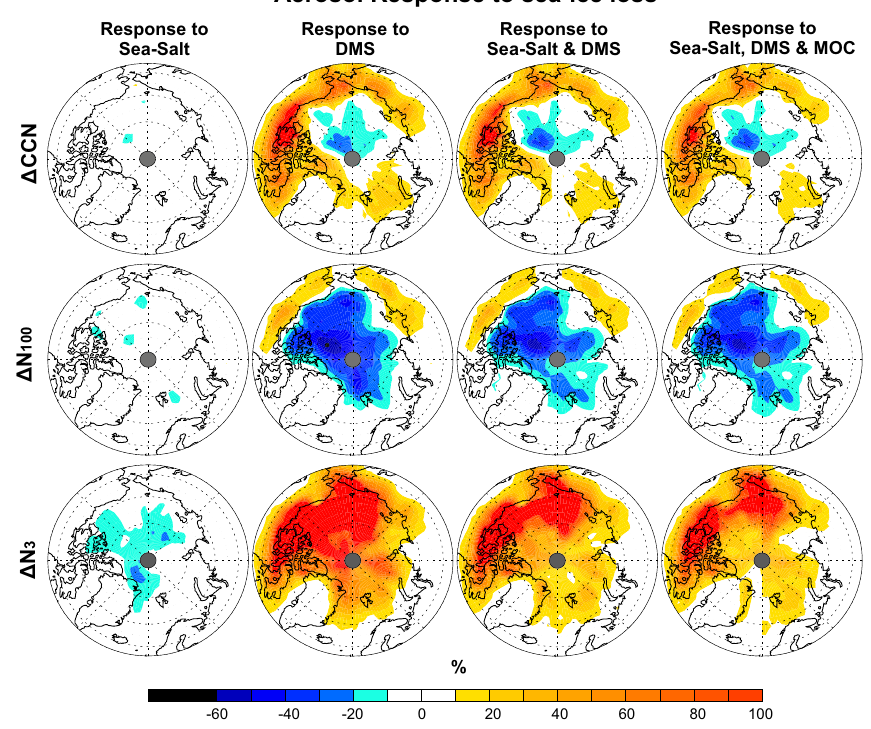
Figure 4. Response of modelled surface level aerosol concentrations due to complete loss of sea ice: CCN (top), N 100 (middle) and N 3 (bottom). Different aerosols and precursors are allowed to respond to the ice loss: sea-salt flux (column 1), DMS flux (column 2), sea-salt and DMS flux combined (column 3) and all aerosol (sea-salt, DMS and marine organic carbon flux) (column 4).